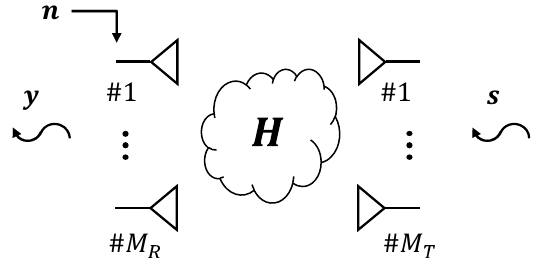
Figure 2. Signal model of the MIMO antenna